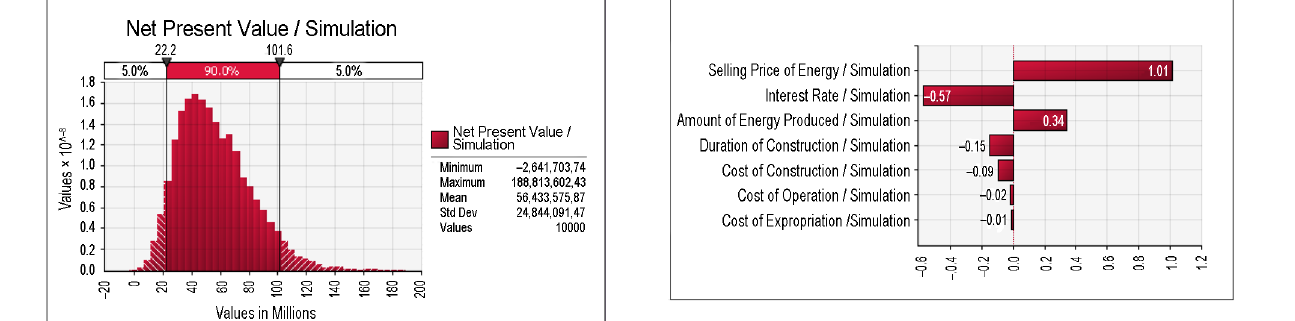
Fig. 3. Tornado graph of cash flow